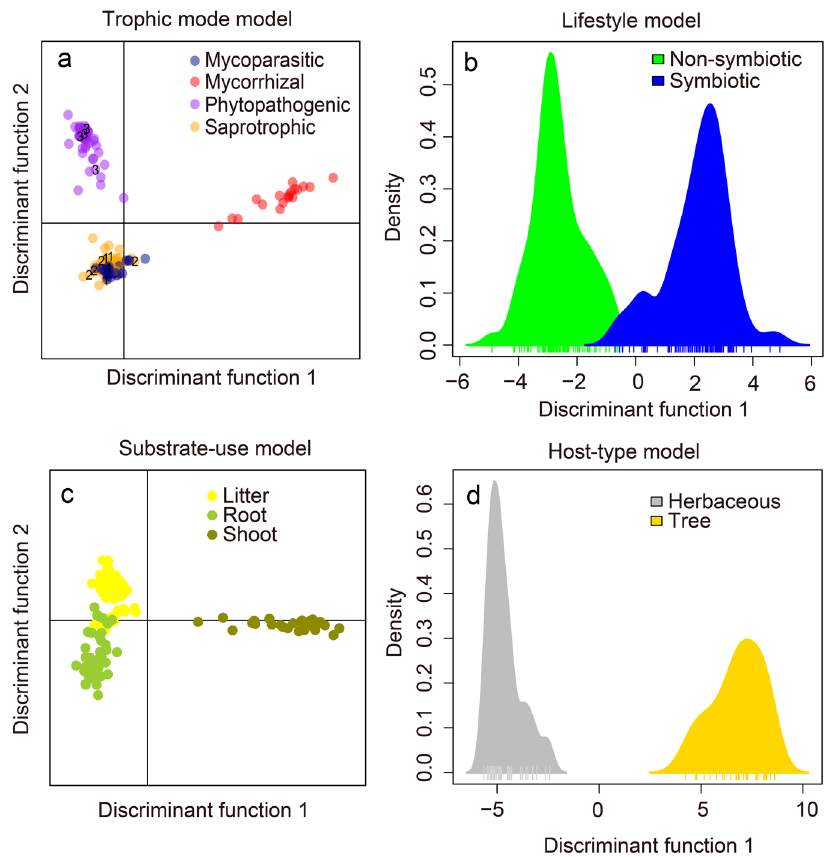
Fig. 4 Functional characterization of fungi using the complete fungal volatile organic compound (fVOC) pro fi les. The discriminant analysis of principal components (DAPC) models comprise trophic mode ( a ), (non)symbiotic lifestyle ( b ), substrate-use ( c ), and host-type ( d ) models. a , c Scatter plots with dots denoting individual fungus; b , d Density plots, with ticks denoting individual fungus. The numbers in a indicate the fungal species easily moving among trophic modes ( Alternaria alternata (#1) and Aspergillus niger (#2)) were grouped to saprotrophs, Fusarium oxysporum (#3) to phytopathogens (for details refer to Supplementary Table S1 51 ). Detailed parametric con fi gurations of DAPC models are provided in the “ Methods ”